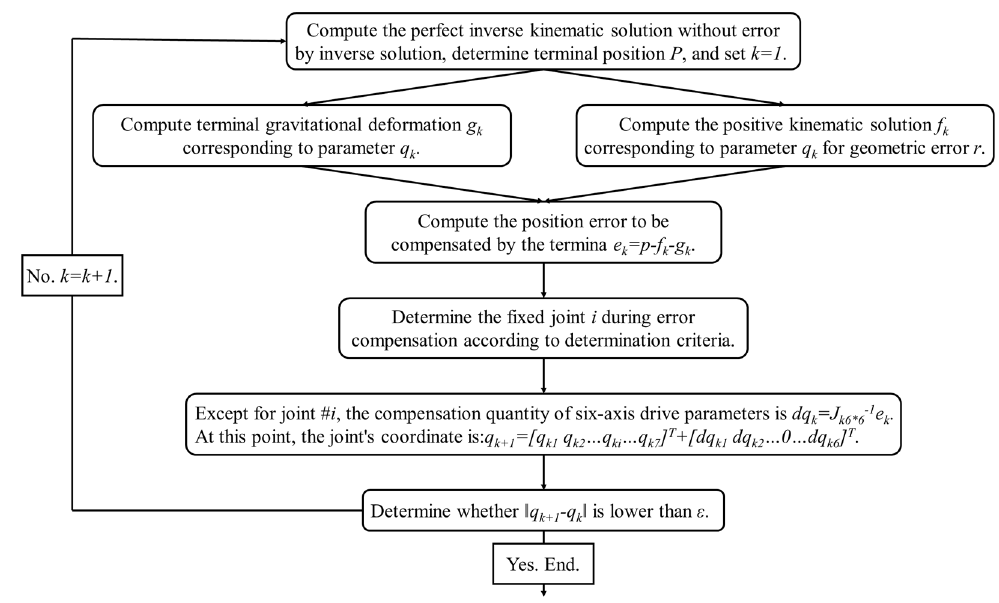
Figure 6. Flowchart of error compensation of 7-DoF spray-painting robots.